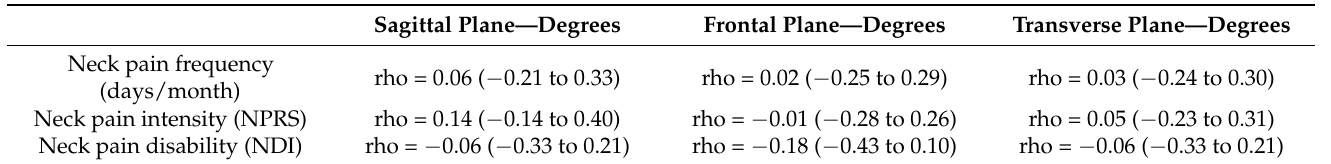
Figure 3. Association between PHQ scores and cervical range of motion (ROM). PHQ: Patient Health Questionnaire. Table 3. Correlation (95%CI) between cervical range of motion and neck pain features in patients with migraine who report neck pain ( n = 53).